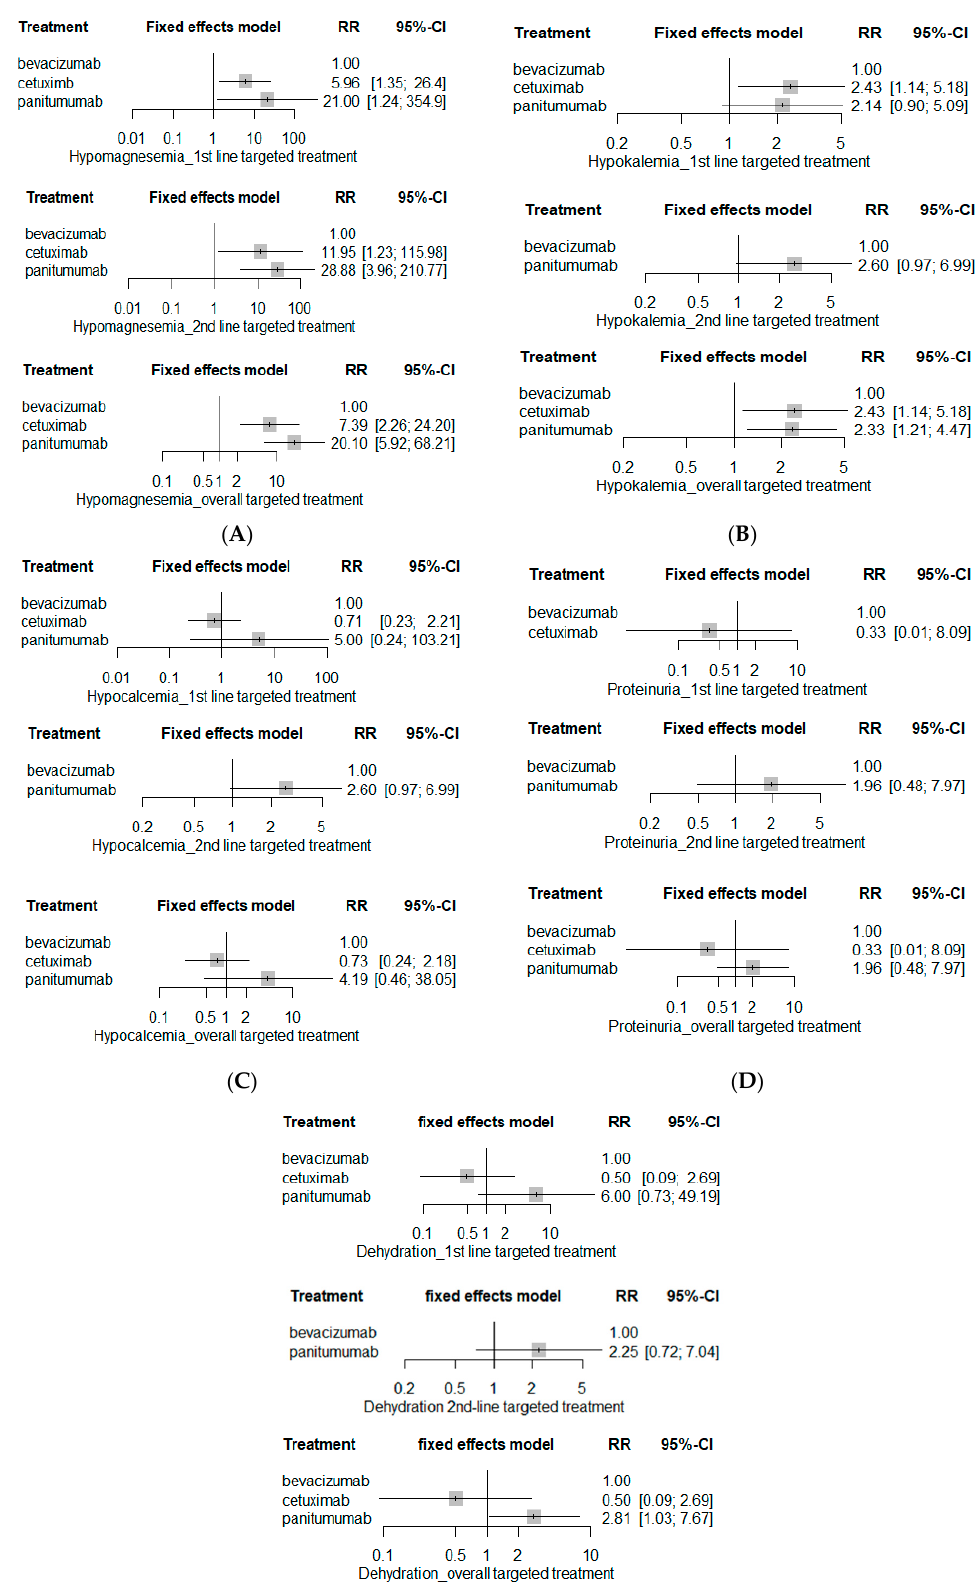
Figure 9. Renal SAE risk. ( A ) Hypomagnesemia; ( B ) hypokalemia; ( C ) hypocalcemia; ( D ) proteinuria; and ( E ) dehydration.